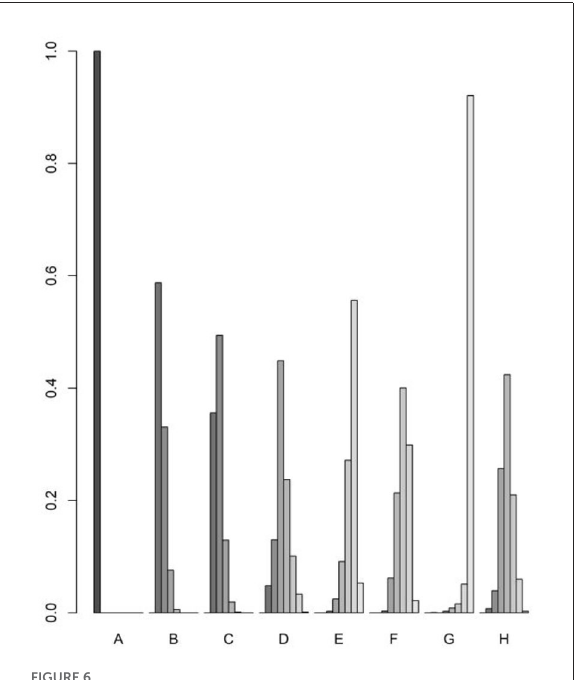
FIGURE5 Probability diagram. FIGURE6 Cumulative probability